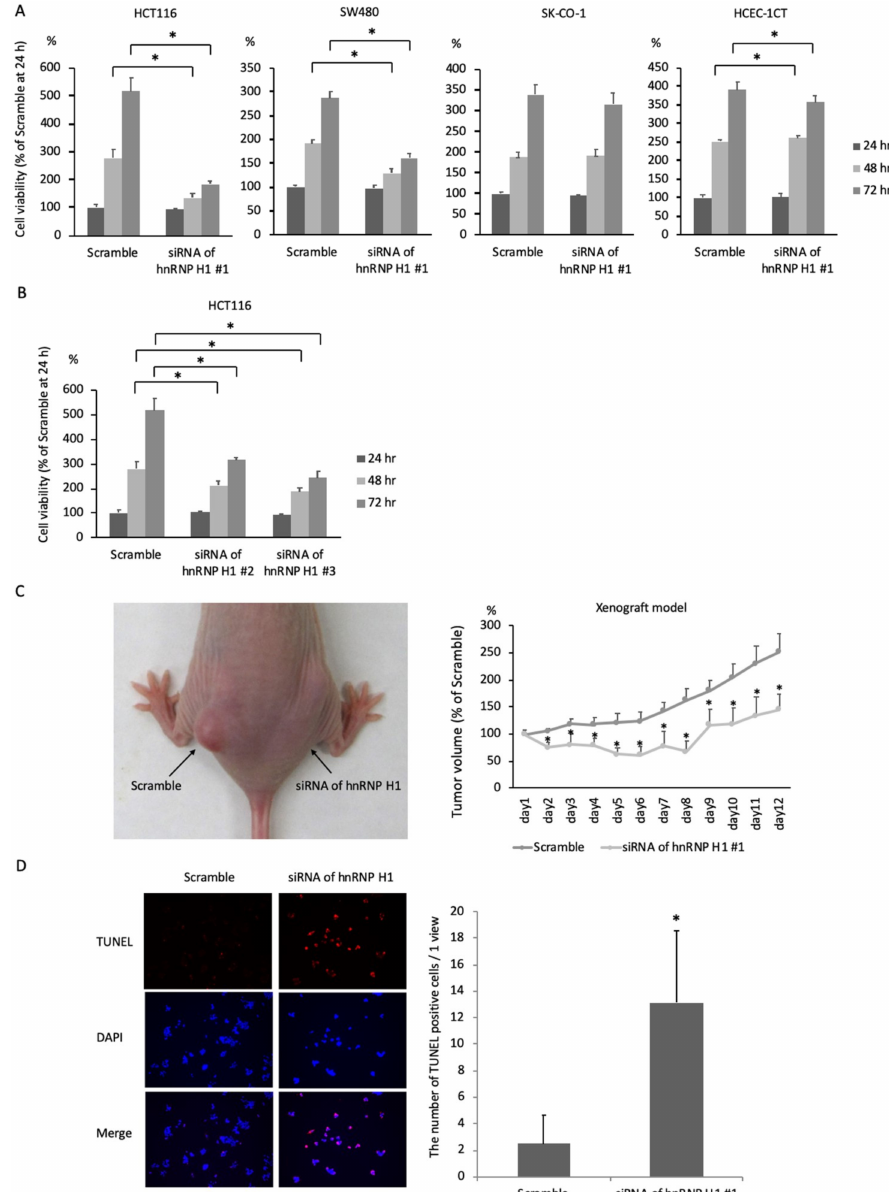
Figure 1. Heterogeneous nuclear ribonucleoprotein H1 (hnRNP H1) promoted cell progression by inhibiting apoptosis in colorectal cancer cells. ( A ) The sulforhodamine B (SRB) assay ( n = 5) showed that cell growth was significantly reduced in HCT116 and SW480 cells transfected with an siRNA of hnRNP H1 compared with those transfected with scrambled RNA. The SRB assay ( n = 5) showed that cell growth was suppressed to a lesser degree or not at all by the downregulation of hnRNP H1 in HCEC-1CT or SK-CO-1 cells. ( B ) The SRB assay ( n = 5) showed that cell growth was significantly reduced in HCT116 cells transfected with siRNAs of hnRNP H1 #2 and #3 compared with cells transfected with scrambled RNA. ( C ) HCT116 cells were transplanted into nude mice, and the siRNA of hnRNP H1 #1 or scrambled RNA was injected daily. Tumor growth was significantly reduced by treatment with the siRNA of hnRNP H1 #1. ( D ) The number of terminal deoxynucleotidyl transferase dUTP nick-end labeling (TUNEL)-positive cells was significantly higher in HCT116 cells transfected with the siRNA of hnRNP H1 #1 than in those transfected with scrambled RNA. The error bars show the standard deviation (SD). * p < 0.05 by Student’s t